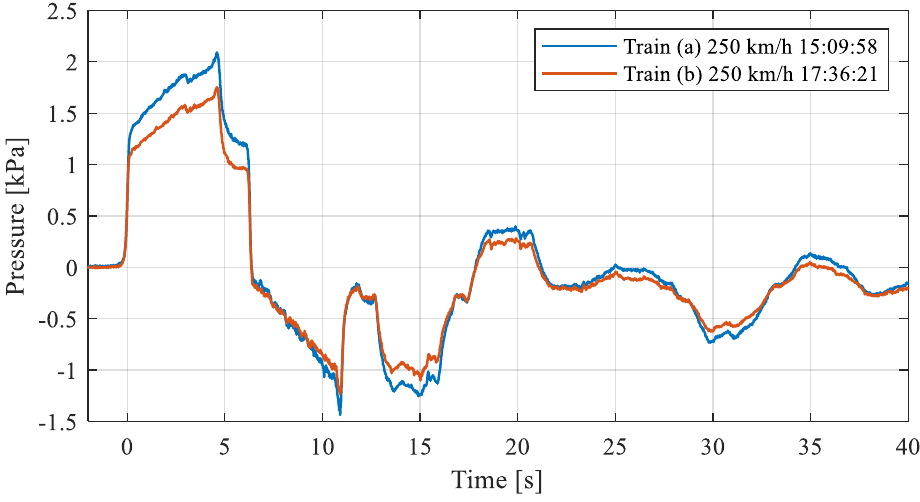
Figure 5. Measured Δ P max of the 203 single train passages as a function of train speed.